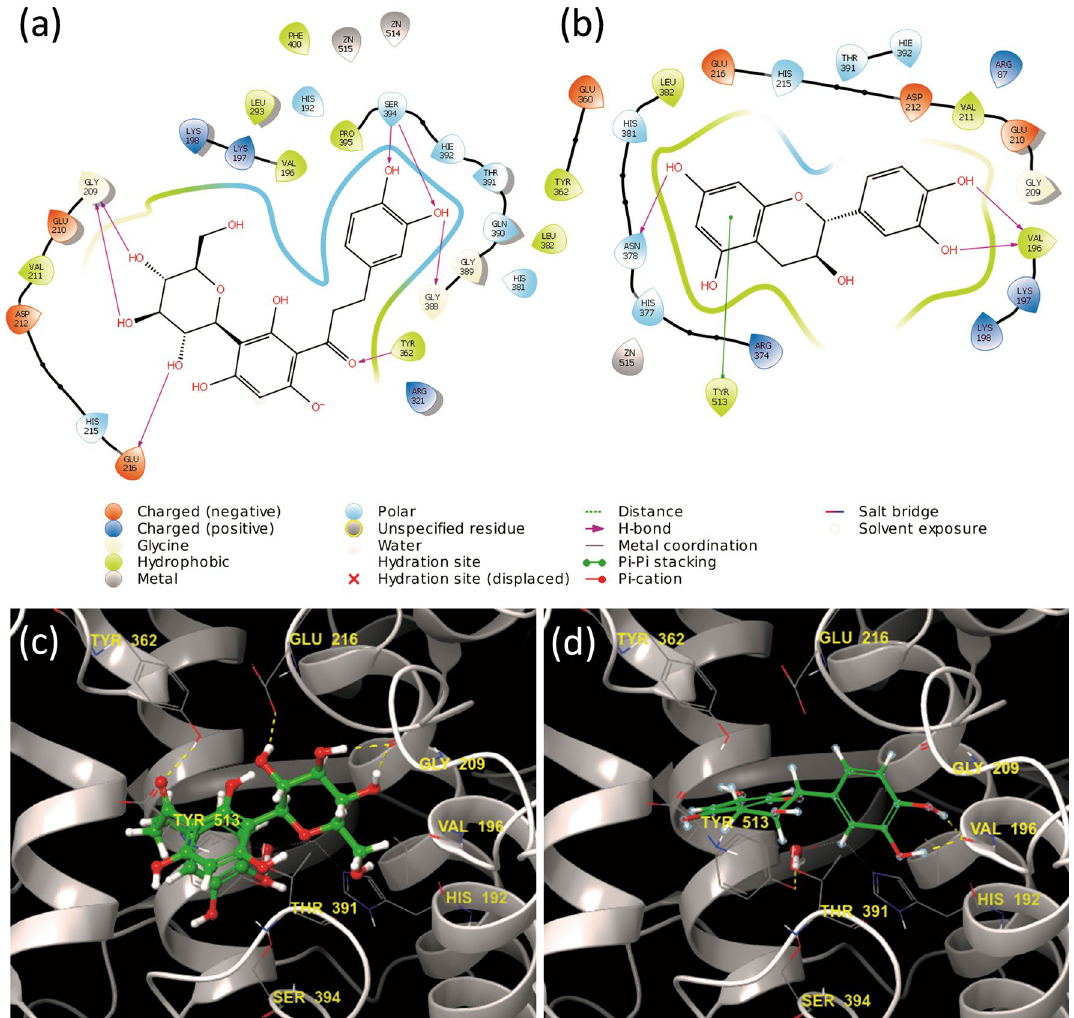
bonds between aspalathin ( 1 ) and tyrosine 362, glycine 209 and glutamine 216, and catechin ( 3 ) and valine 196, threonine 391, tyrosine 362 and asparagine 378, and pi-pi stacking of the benzyl ring with histidine 215. Hydrogen bonds are represented by yellow dashed lines in images ( c ) and ( d ) (https:// www. schro dinger. com/ maest ro ; version 12.1 . 013, release